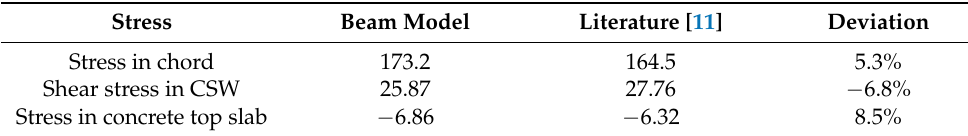
Figure 4. Loading rig for fatigue performance test: ( a ) sketch of loading rig; and ( b ) photograph of loading rig. Table 2. Verification of integral FE model (unit: MPa).